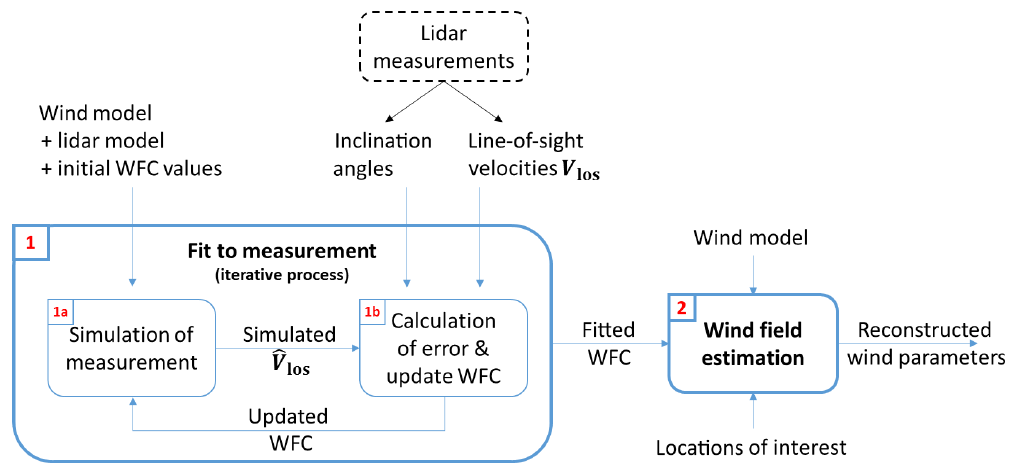
Figure 1. Flow chart of the model-fitting Wind Field Reconstruction